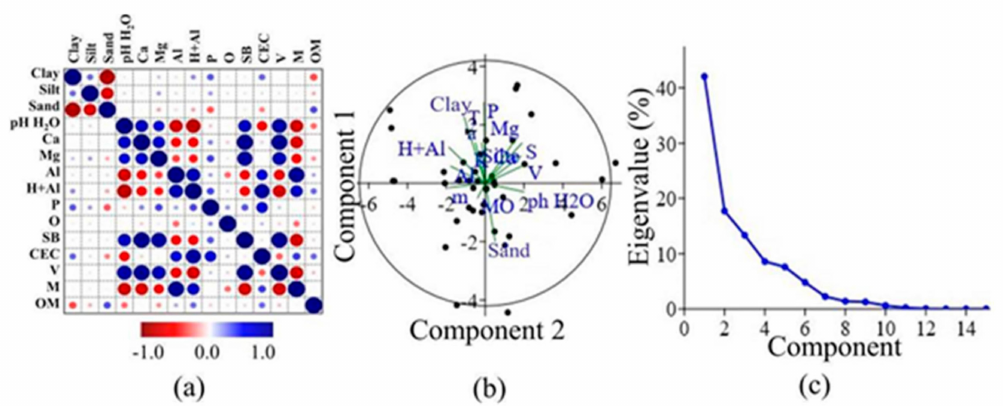
Figure 3. Pearson correlation between soil attributes ( a ), principal component analysis ( b ), and eigenvalues ( c ) of the soil diagnostic horizons.